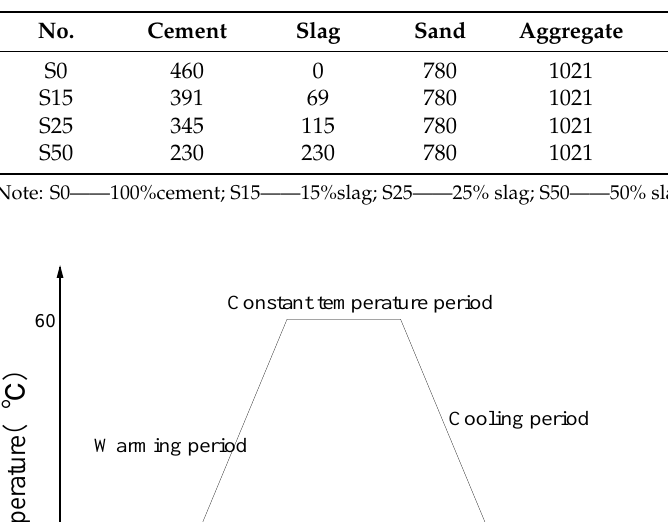
Table 2. Mix proportion of concrete (kg·m − 3 ).